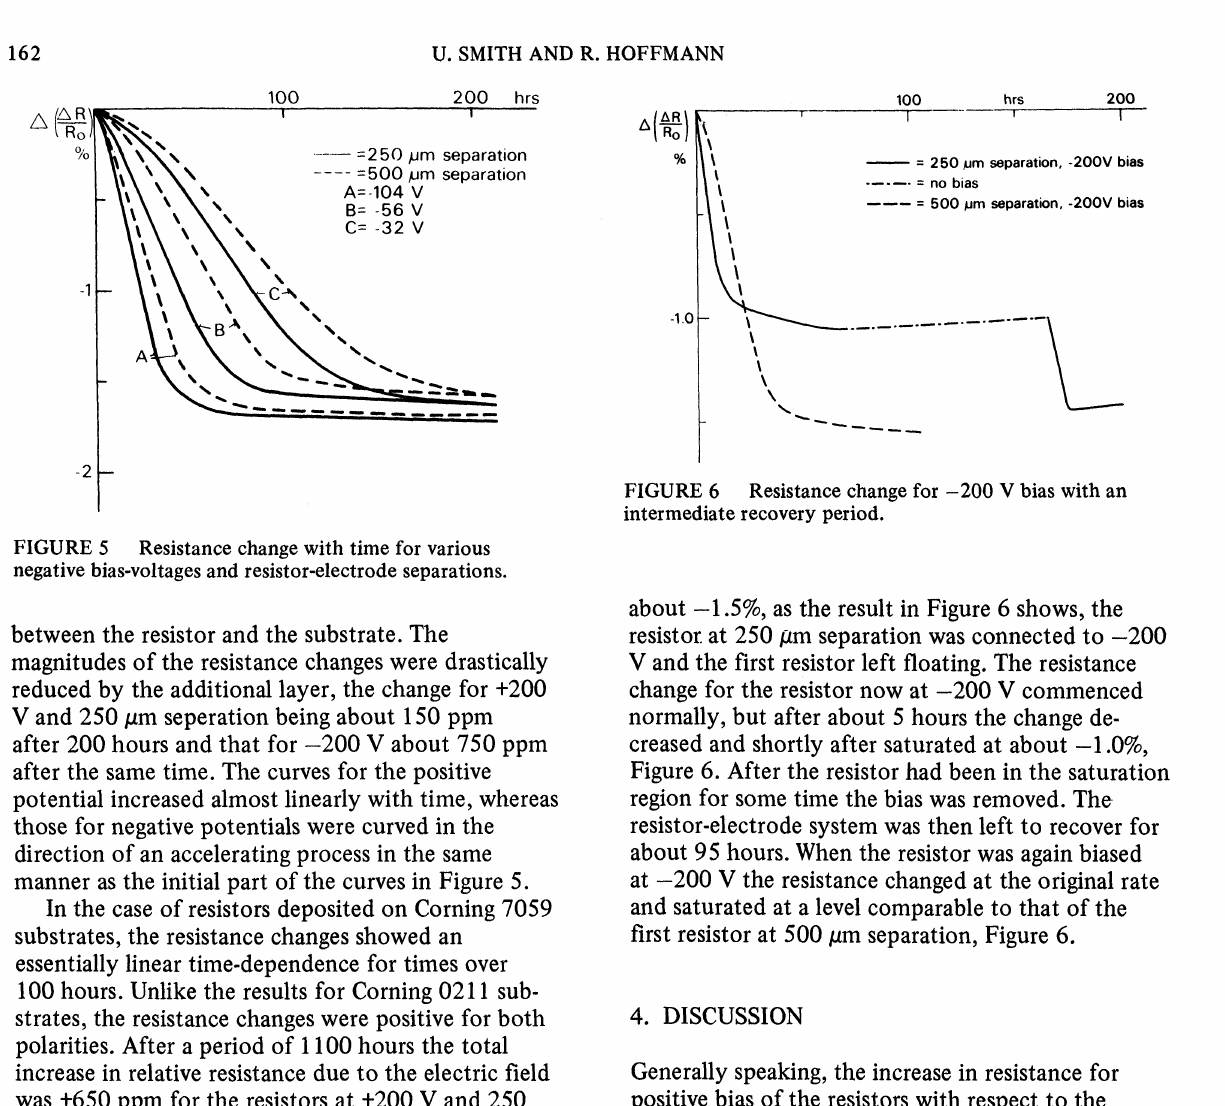
Resistance change for -200 V bias with an intermediate recovery period.